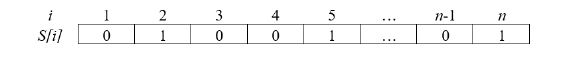
Figure 3. Binary representation of a KP